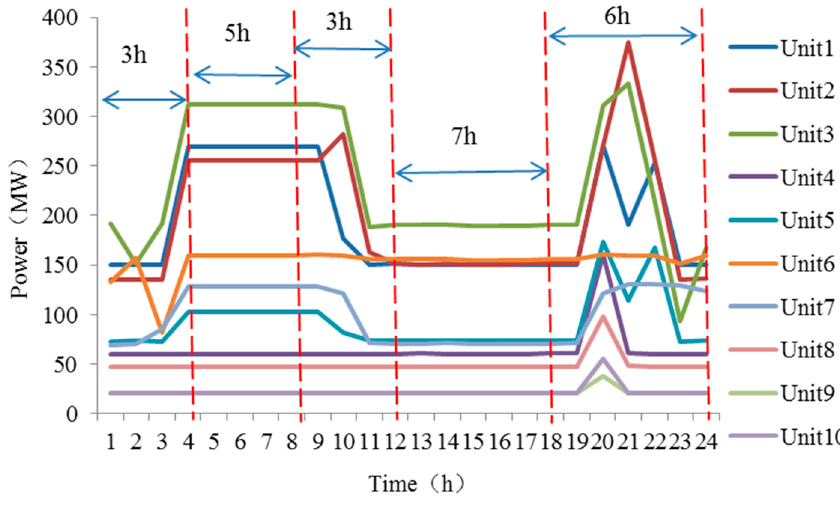
Energies 2018 , 11 , x FOR PEER REVIEW Figure 19. Power output curves of thermal generators in Case 4. Figure 19. Power output curves of thermal generators in Case 4.